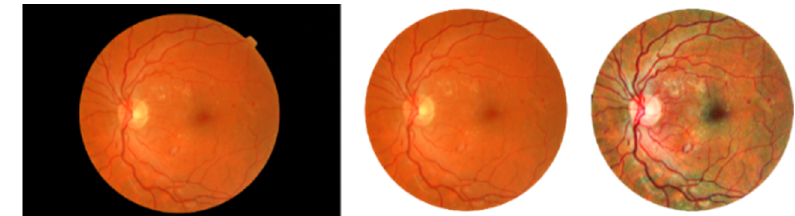
Figure 8. Original Fundus Image, Result of Cropping Image, Result of CLAHE.